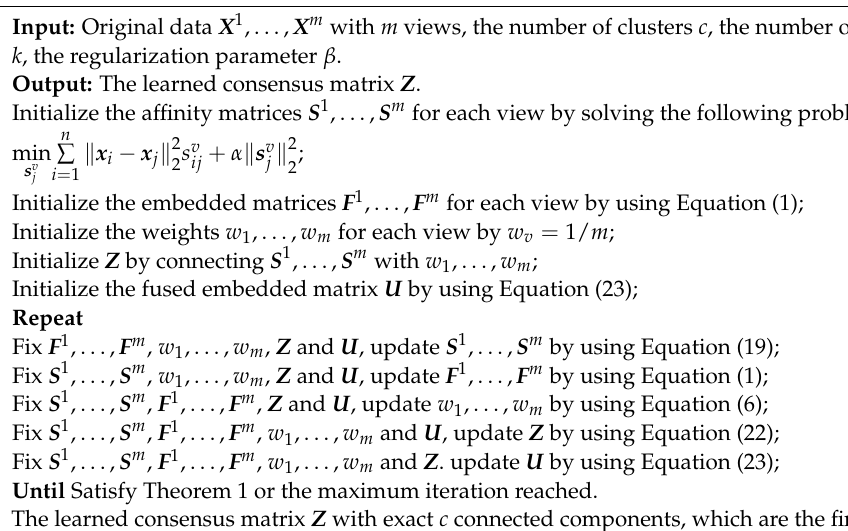
Algorithm 1. LRCMC